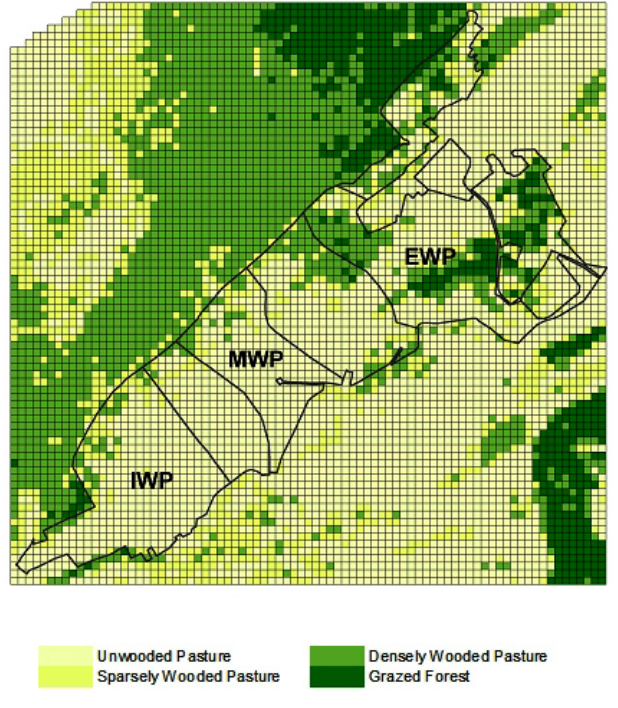
Fig. 2 . Regionalized observed (1950–2000 AD) and simulated (2000–2050 AD) annual temperatures (thin solid lines) and vegetation growing season temperatures (thick solid lines) for two scenarios from the Intergovernmental Panel on Climate Change Special Report Emissions Scenarios (IPCC-SRES 2000): B2 (dark grey) and A1FI (light grey). The average temperature of the vegetation periods from 1961 to 2010 is presented as a reference threshold (thick dashed black line). The difference between simulated yearly temperatures of vegetation periods and this reference threshold is implemented as a parameter D T driving drought stress in simulations. The average temperature of the last 50 years (thin dashed line) is used to simulate the increase in productivity due to the prolongation of the vegetation